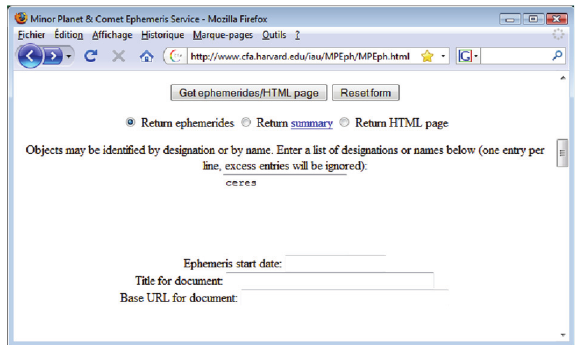
Figure 2: Web form of the Minor Planet Center ephemeris center as seen using a